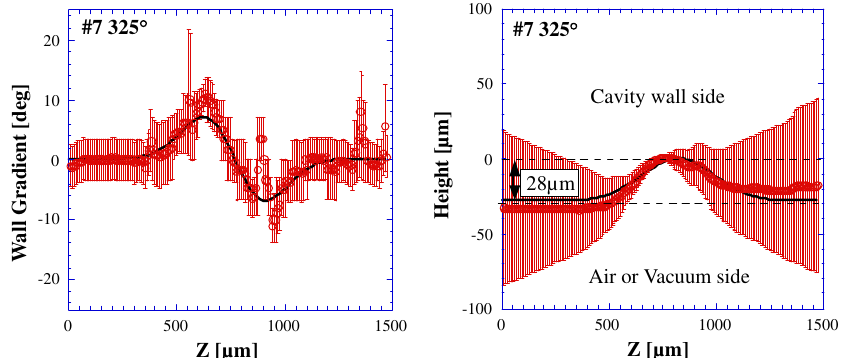
FIG. 13. (Color) Gradient and height of the spot shown in Fig. 9. This example shows a concave spot